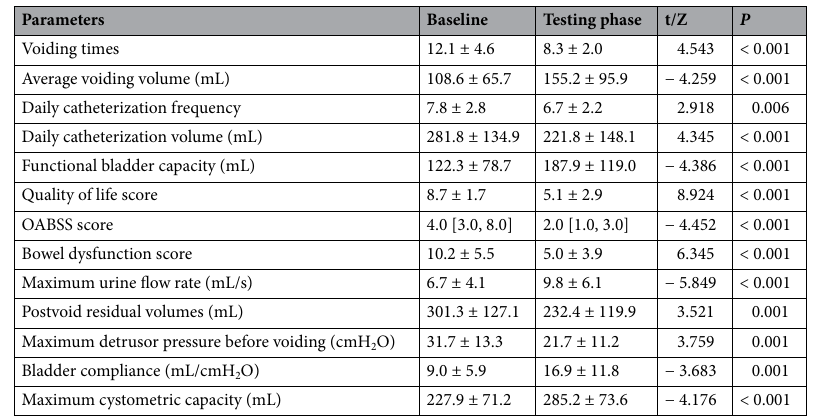
Table 2. Comparison of data from baseline and testing phase of 52 patients with NB who underwent SNM treatment. OABSS overactive bladder symptom